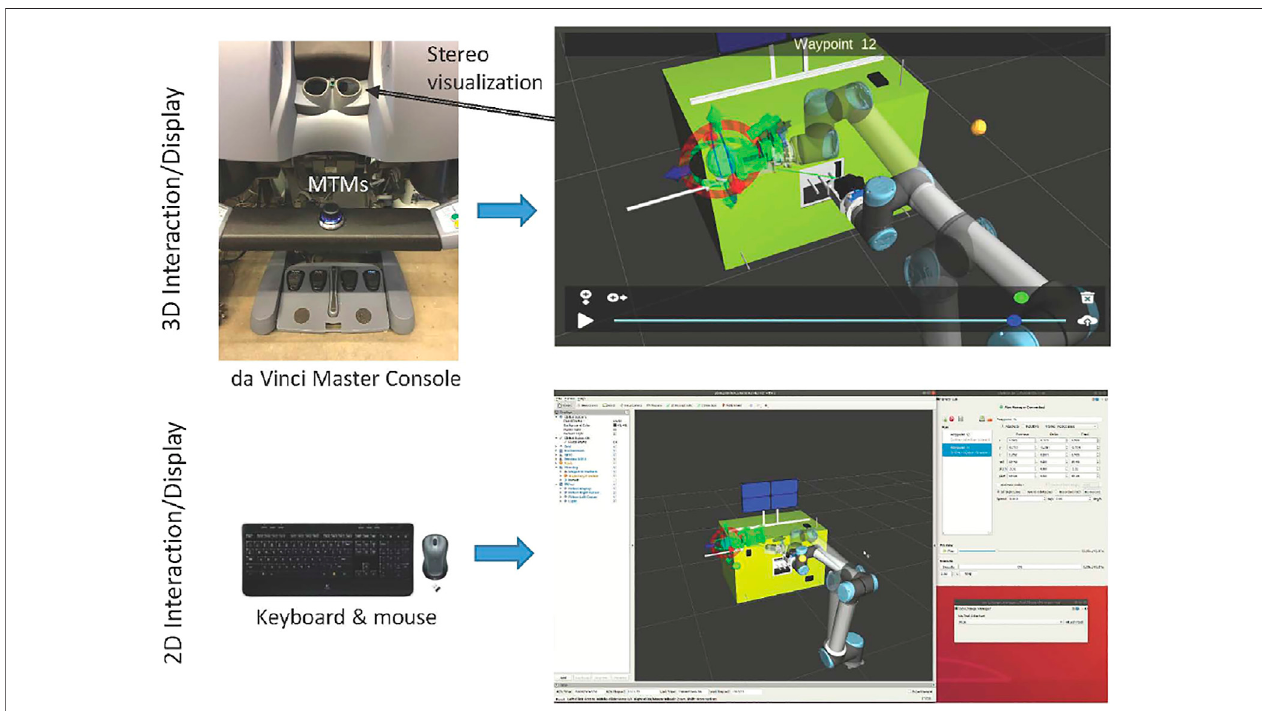
FIGURE5| OverviewofInteractivePlanningSystem,showing3Dinterface (top) and2Dinterface (bottom) .ThedaVinciMasterConsoleincludestwoMasterTool Manipulators (MTMs) that enable 3D interaction (for example, to move the interactive cursors) and provides a stereo display for visualization. Both 3D and 2D interfaces are available simultaneously and visualize/update the same